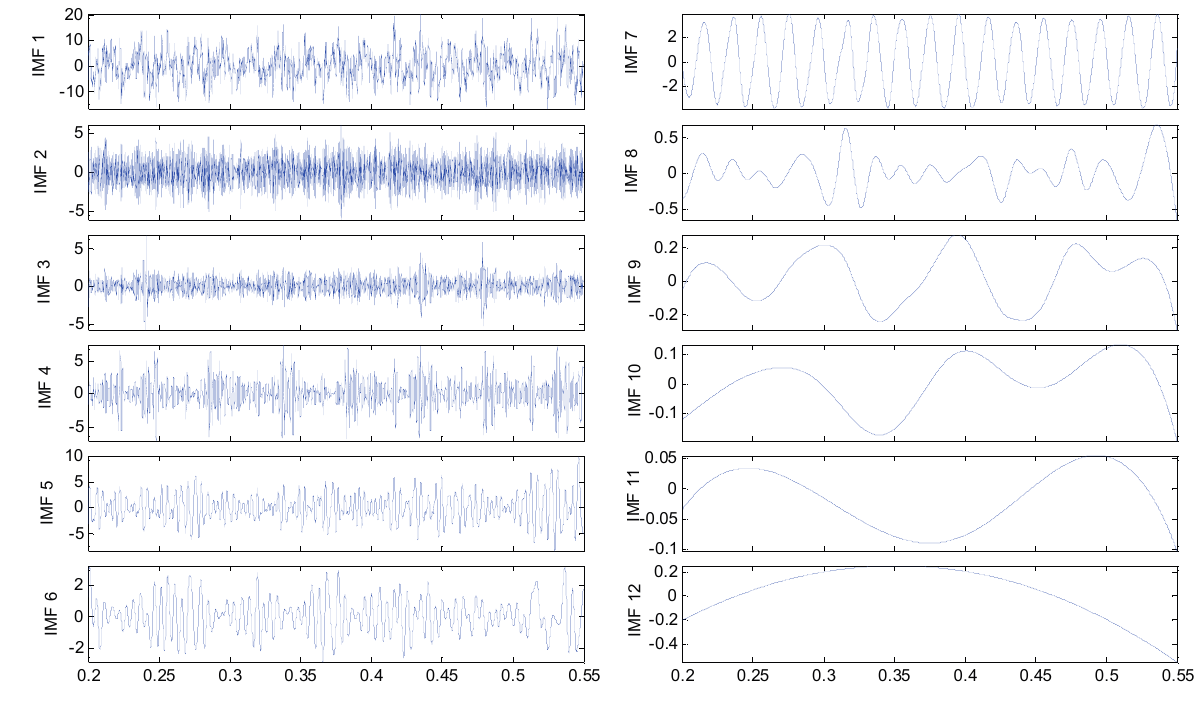
Figure 5. IMFs for the undamaged axle bearing vibration signal.